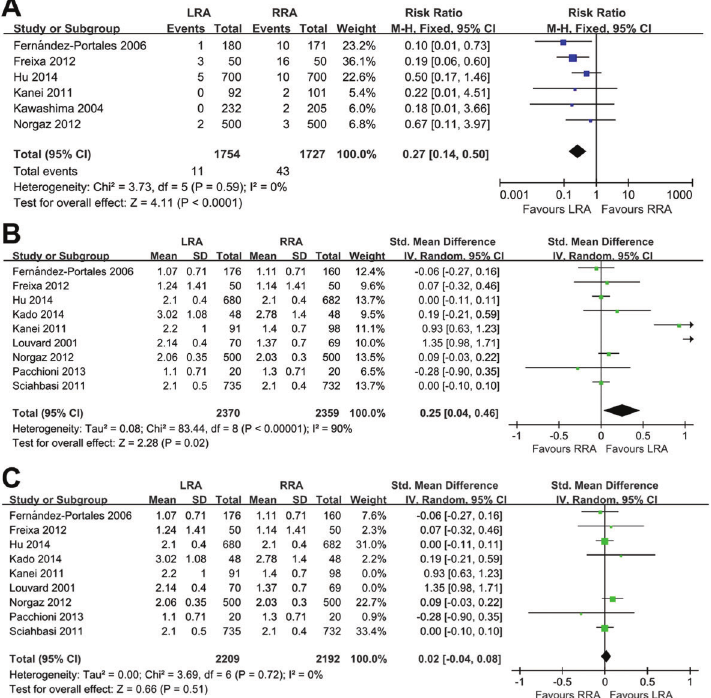
Figure 4. Meta-analysis of subclavian tortuosity and catheter count. A , Comparison of the left radial approach (LRA) versus the right radial approach (RRA) for tortuosity of the subclavian artery. B , Comparison of the LRA versus the RRA for catheter count. C , Sensitivity analysis of the catheter count meta-analysis excluding the stu- dies by Kanei and Louvard (30,31). See Table 1 for numbers of all references